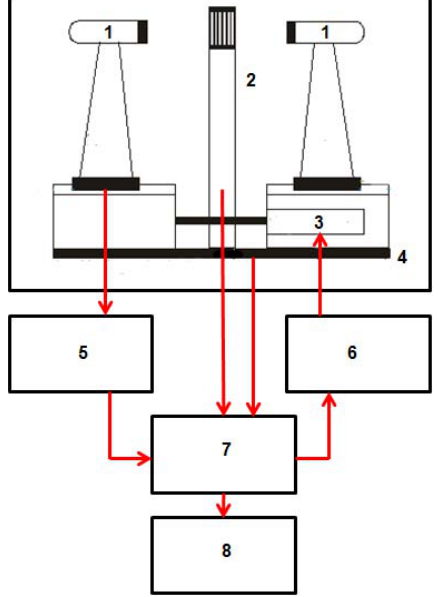
Fig. 4. Block schema of the krypton hygrometer calibration device: 1. KH20, 2. HMP45A, 3. stepper motor, 4. positioning unit with linear slide, 5. amplifier (part of KH20), 6. driver, 7. multifunction- IO, 8: touchpanel PC, the power supply units are not